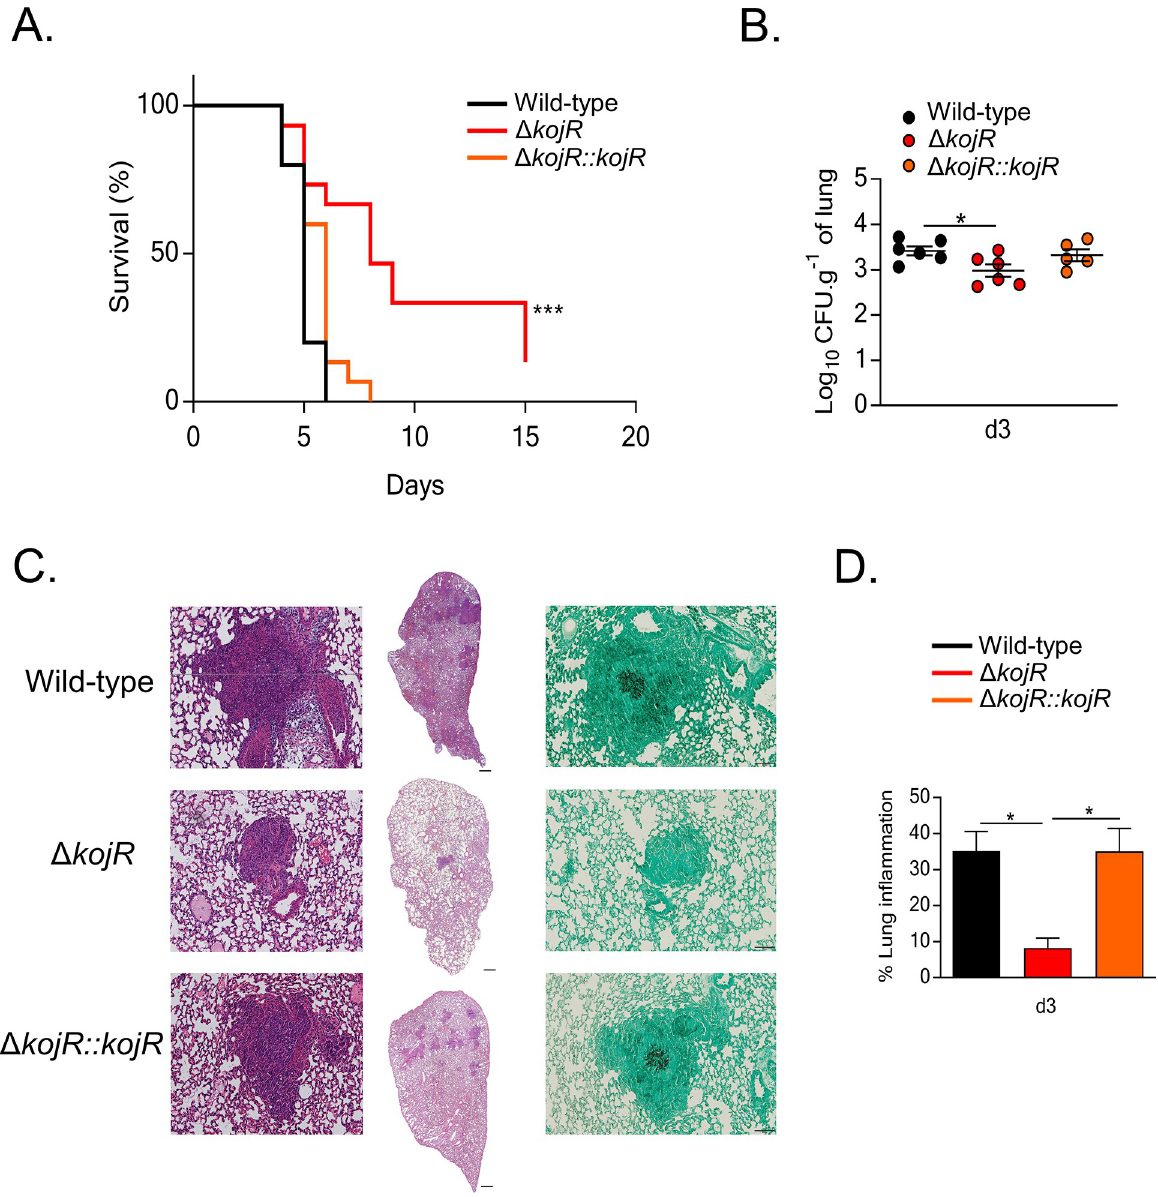
Fig 12. KojR is required for virulence in a mouse model of invasive aspergillosis. - (A) Survival curve (n = 10 mice/strain) infected with the indicated A . fumigatus strains. Phosphate buffered saline (PBS) was administered in a negative control group (n = 5). The indicated P values are based on the log-rank, Mantel-Cox, and Gehan-Breslow-Wilcoxon tests comparing the KojR deletion strain to the WT and complemented strains. (B) Fungal burden in murine lungs after 3 days post-infection (p.i.) with the different strains. Murine lungs were excised, ruptured, and resuspended before dilutions were prepared and incubated on plates containing complete medium. Fungal growth was assessed by counting the colony-forming units (CFU) on the plates for each dilution. (C) Histopathology of mice infected with the different strains. Lungs were excised at 3 days post-infection (p.i.) before lung sections were prepared and stained with hematoxylin and eosin (H&E) and/or with Gomori’s methenamine silver (GMS). (D) Inflammation (expressed as %) in murine lungs after 3 days post-infection (p.i.) with the different strains. Murine lungs were excised, and slides of lungs sections were prepared. To quantify lung inflammation of infected animals, inflamed areas on slide images were analyzed using the thresholding tool in ImageJ software. Values are averages ± standard deviations (error bars) of three biological replicates (lungs from different mice). Values that are significantly different in a two-way multiple comparison ANOVA test are indicated as follows: � p - value < 0.05, ��� p -value < 0.001.